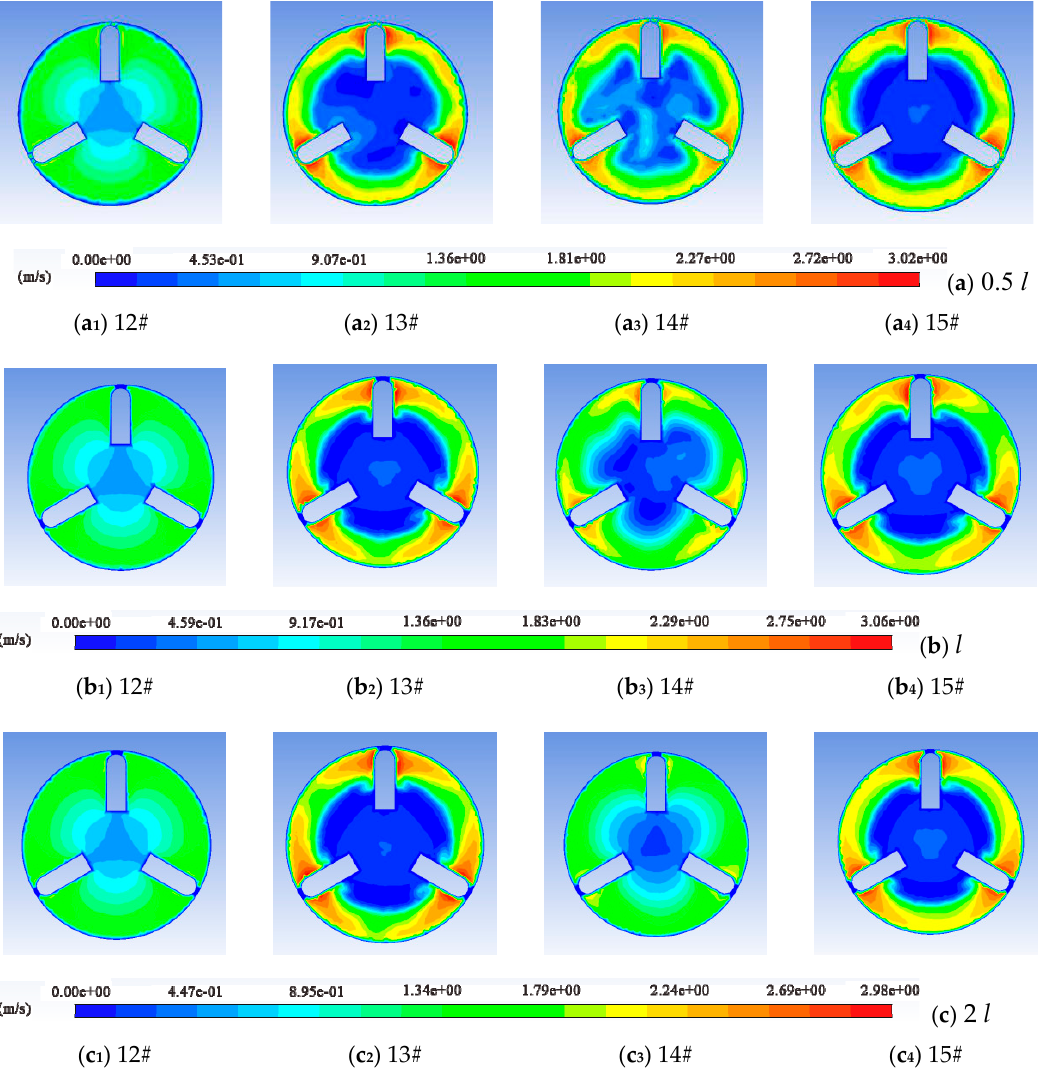
Figure 11. The velocity magnitude distribution cloud map of the support body cross-sections at different vehicle spacings. ( a ) L = 0.5 l . ( b ) L = l . ( c ) L = 2 l . Note: 12# and 13# represent the cross-section of the support body of the left pipe vehicle; 14# and 15# represent the cross-section of the support body of the right pipe vehicle.